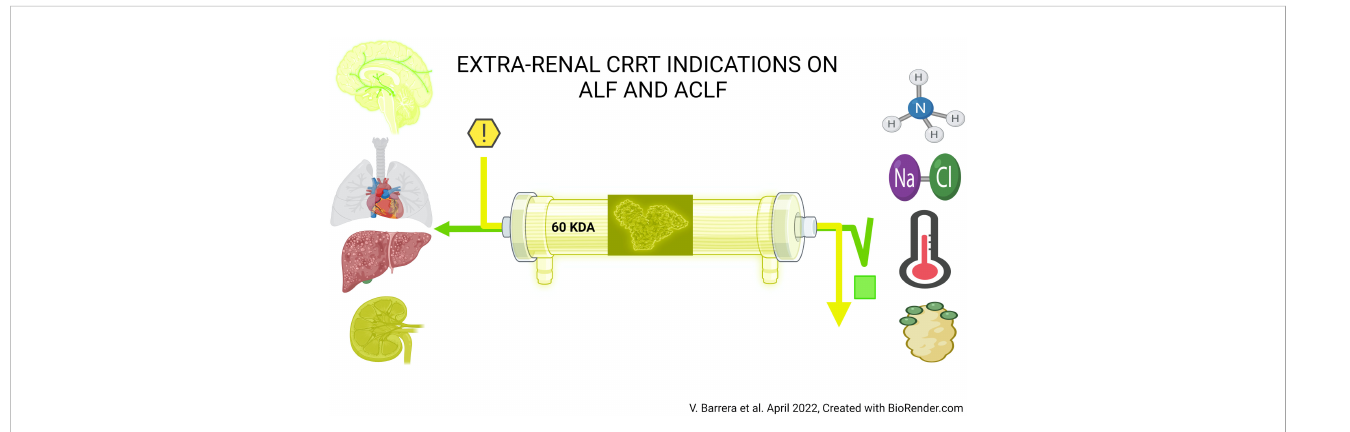
FIGURE 1 Extra-renal CRRT indications on ALF and